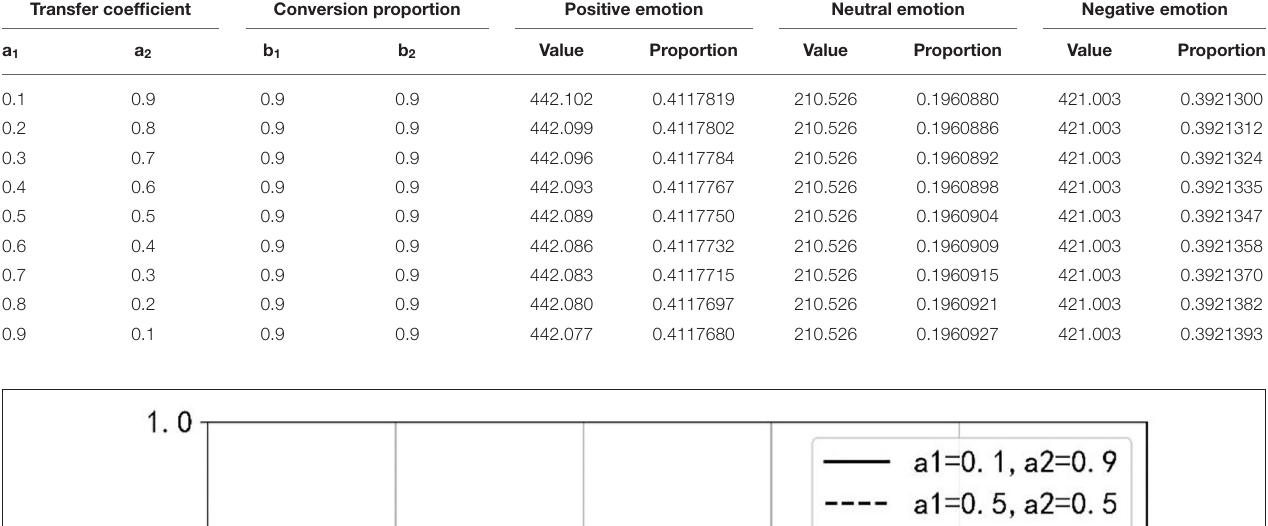
TABLE 3 | Simulation results under the condition of controlling the conversion proportion.